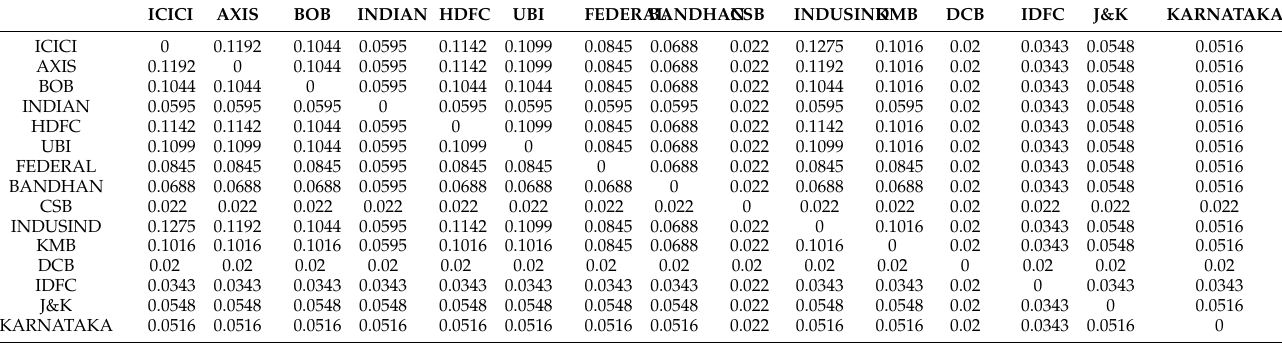
Table 6. Adjacency matrix of the strength of connectedness (1st component).